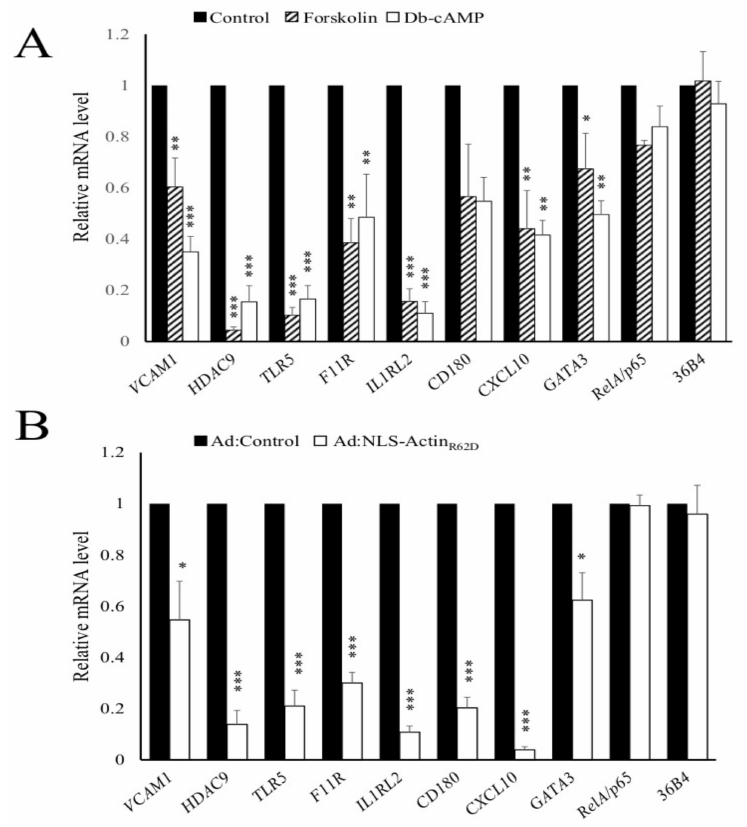
Figure 2. Elevated nuclear actin monomer and cAMP signalling repress basal NF- κ B target gene expression in VSMC. VSMCs were stimulated with 25 µ M forskolin or 200 µ M Db-cAMP for 6 h. Total RNA was isolated 24 h post infection and analysed for mRNA levels of NF- κ B target genes by RT-qPCR (( A ); n = 5). VSMCs were infected with either Ad:Control or Ad:NLS-Actin R62D ( B ). Total RNA was isolated 24 h post infection and analysed for mRNA levels of NF- κ B target genes by RT-qPCR (( B ); n = 4). One way ANOVA with Student Newman Keuls post test; * indicates p < 0.05, ** indicates p < 0.01, *** indicates p <